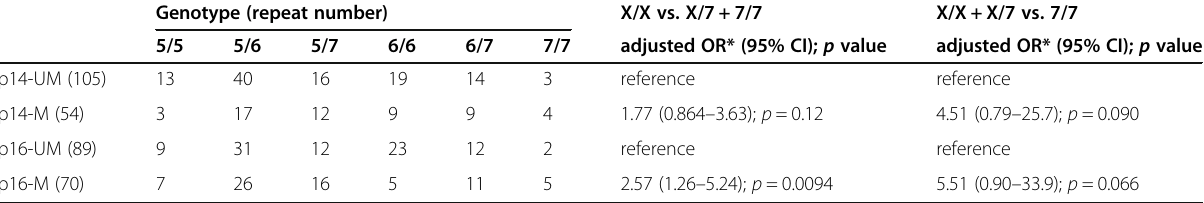
Table 4 Association between MIF rs5844572 and CDKN2A methylation Genotype (repeat number)